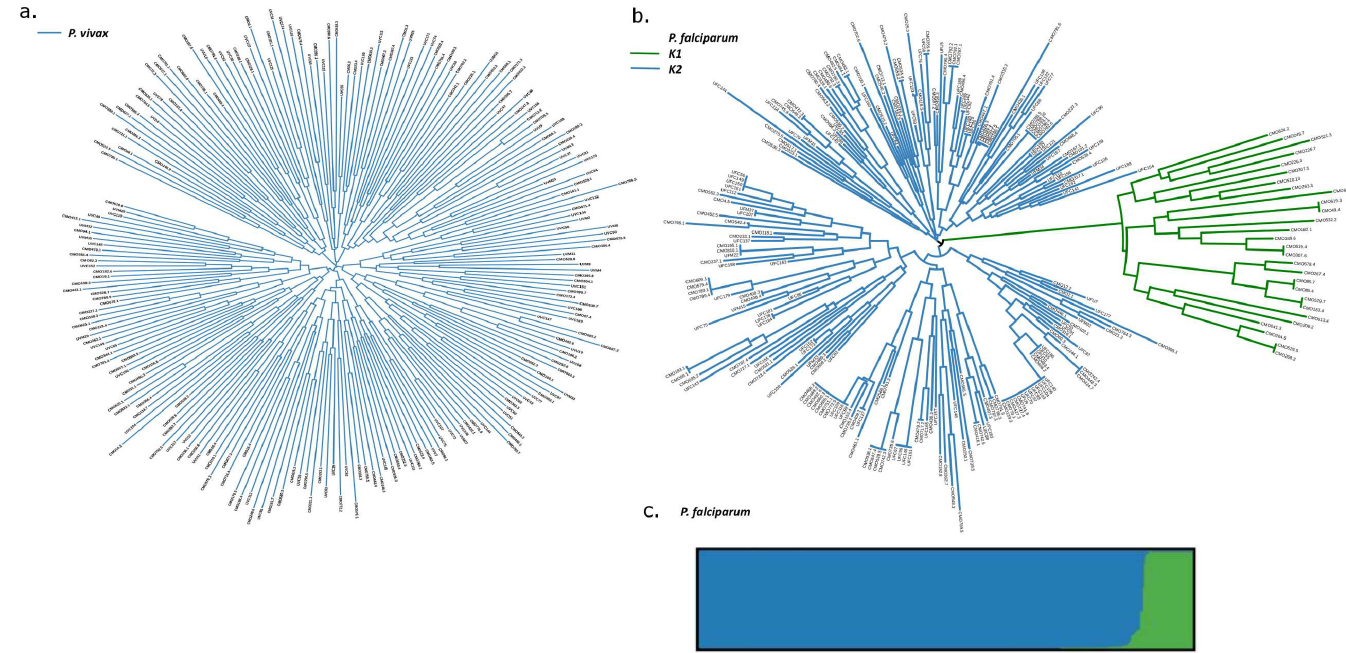
Fig 1. Neighbour-joining and STRUCTURE plots illustrating the genetic diversity and structure in the P . vivax and P . falciparum populations in Timika. Panels A) and B) present unrootedneighbour-joiningtrees illustrating the geneticrelatednessamongst P . vivax and P . falciparum isolates, respectively.Panel C) presents a bar plot illustratingthe substructure in the P . falciparum population at K = 2. Each vertical bar represents an individual sample and each colour represents one of the K clusters (sub-populations) definedby